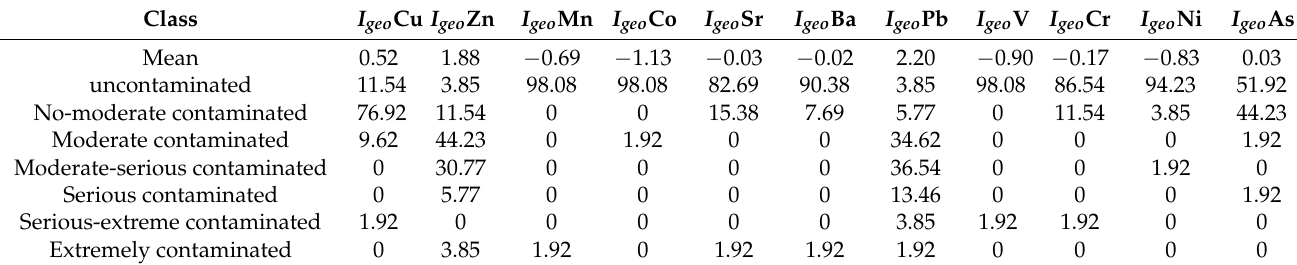
Table 4. A summary of the statistics related to the proportion of dust samples at different geoaccu- mulations (pollution (%)).